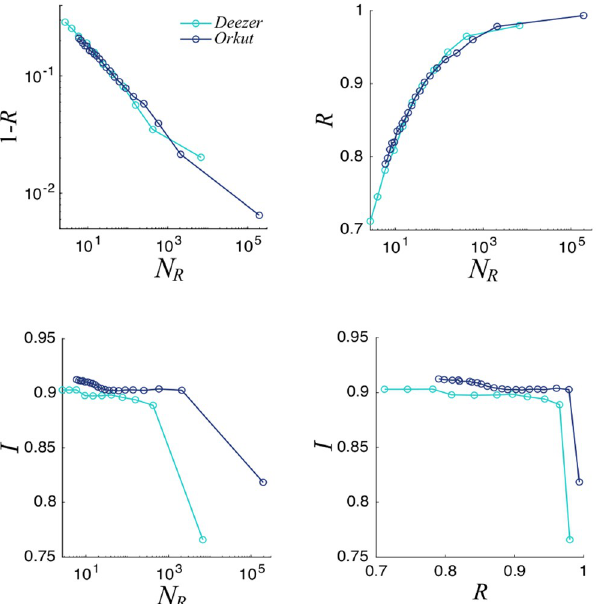
Fig 6. Top: On the left, logarithmic plot of 1 − R versus committee size. On the right, R versus committee size. Bottom: Commitee Integrity as a function of R (left) and committee size (right). We consider the two social networks, Deezer and Orkut. Results are averaged over 100 different realizations; s 2 ¼ s 2